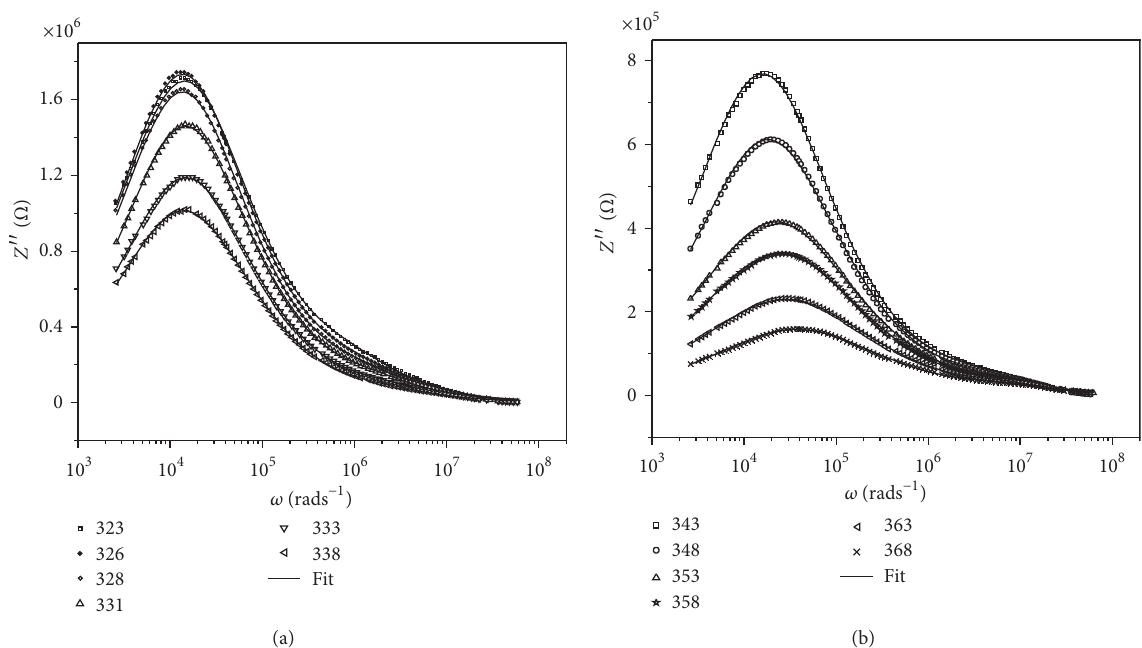
F 8: Frequency dependence of imaginary part of impedance of